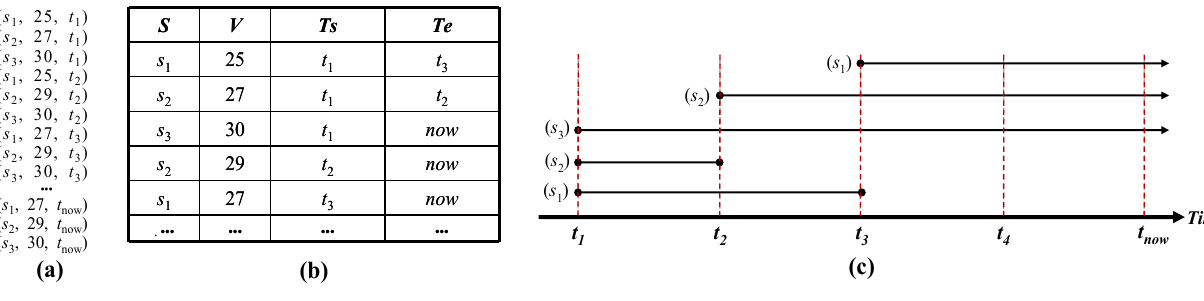
Figure 1. Processing of TSI method ( a ) incoming data stream; ( b ) storage of table in memory; ( c ) time-segments representing the lifetimes of the